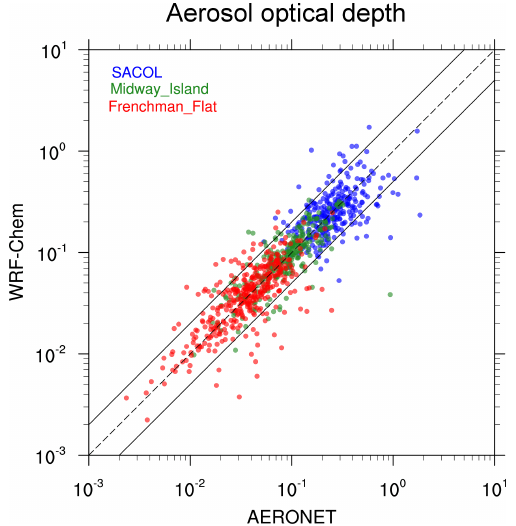
Figure 6. The AERONET observations of daily AOD at 550nm at the three sites (SACOL, Midway Island, and Frenchman Flat) vs. the corresponding WRF-Chem simulation for the period 2010– 2014.